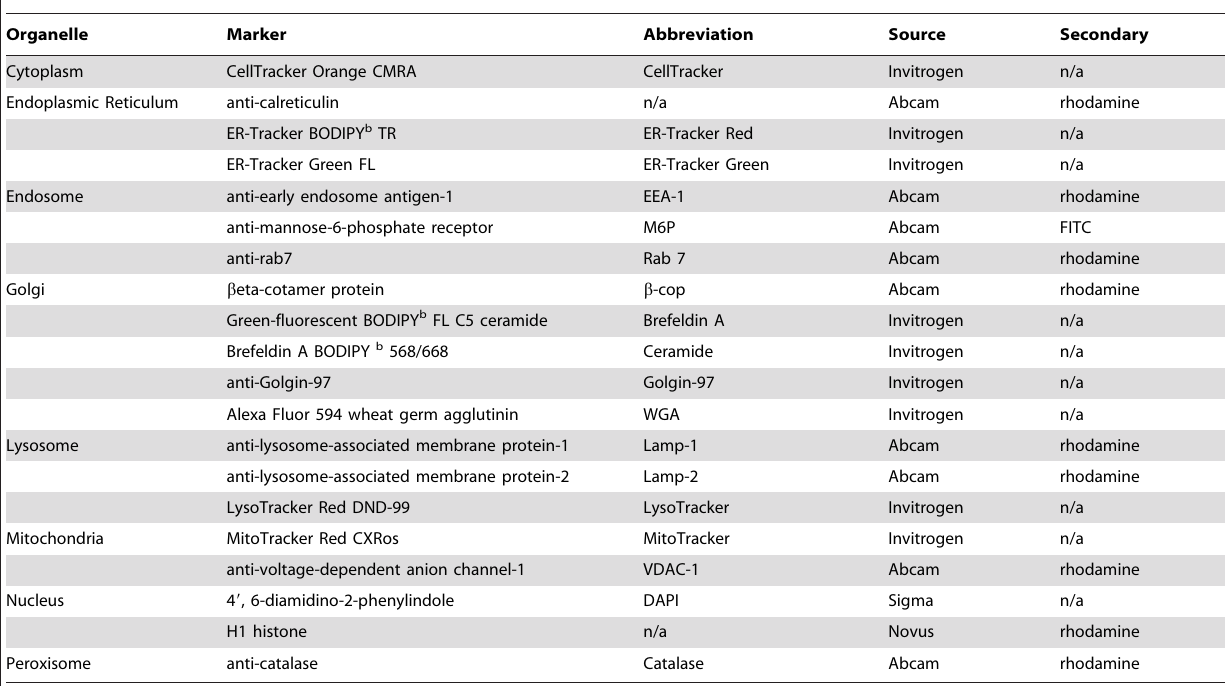
Table 1. Organelle-associated antibodies and